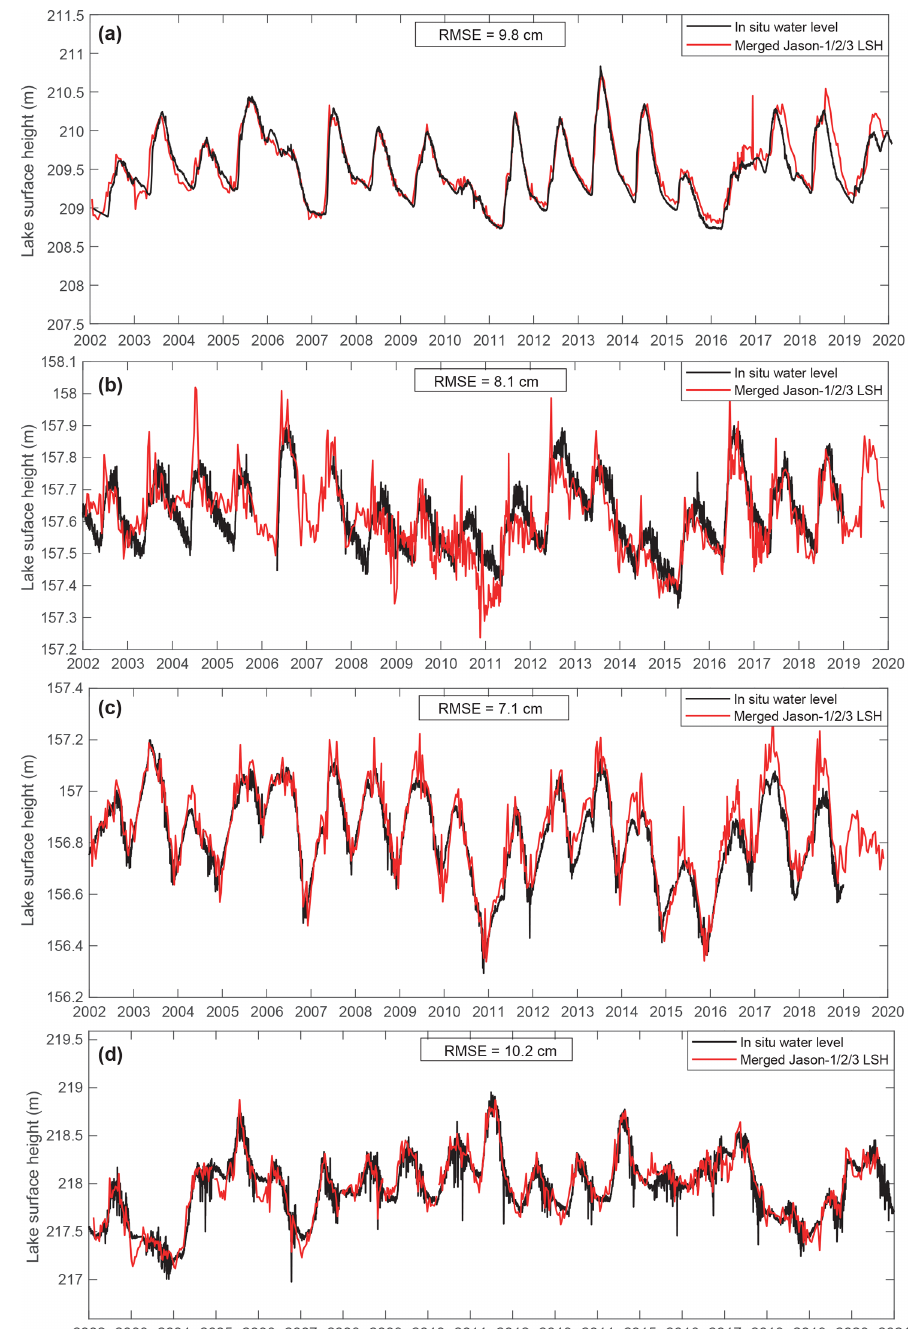
Figure 10. Time series of merged altimetric water levels in Athabasca Lake, GBL, GSL, and Winnipeg Lake. Black curves denote in situ lake water levels and red curves denote merged altimetric LSH for (a) Athabasca Lake, (b) GBL, (c) GSL, and (d) Winnipeg Lake. Note that there are systematic biases between Jason-1/2/3 data, which were removed by comparing the mean LSH during the overlapping periods between Jason-1 and Jason-2 (July 2008–January 2009) and Jason-2 and Jason-3 (February–September 2016).